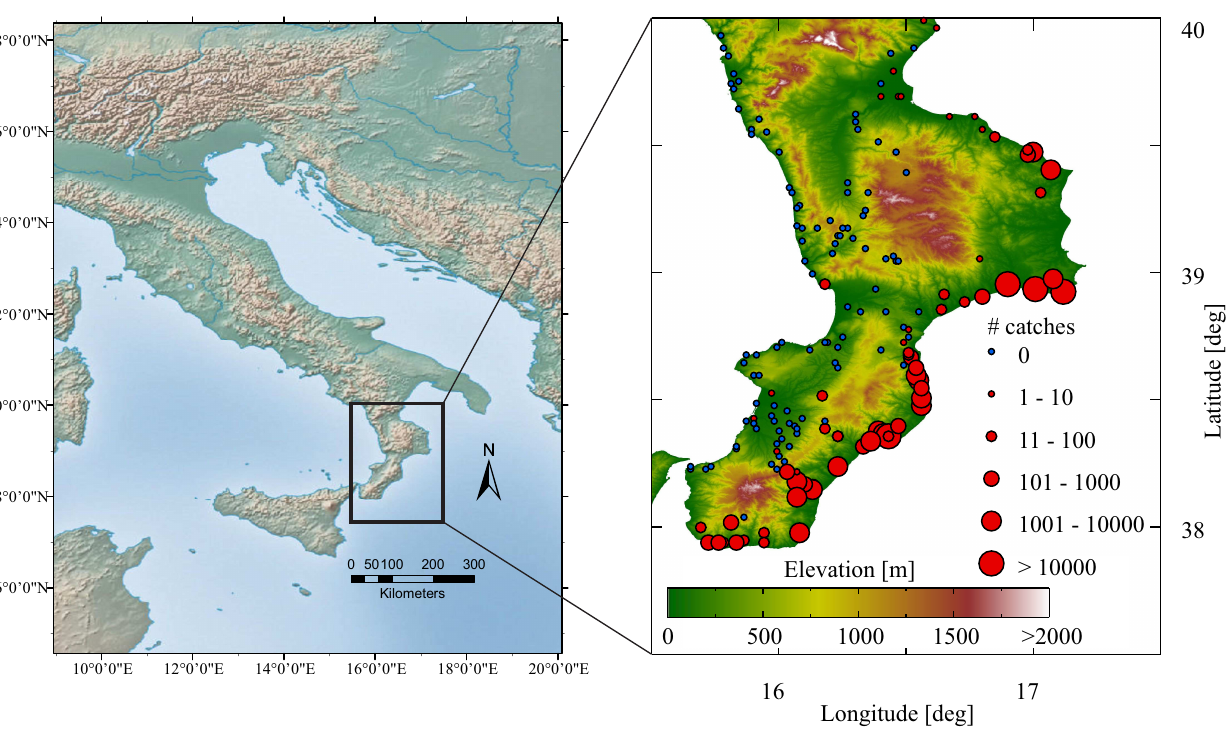
Figure 1. Topography of the study site (Shuttle Radar Topography Mission digital elevation model) and C. imicola catch abundances for the years 2000 and 2001 (Entomological National Surveillance